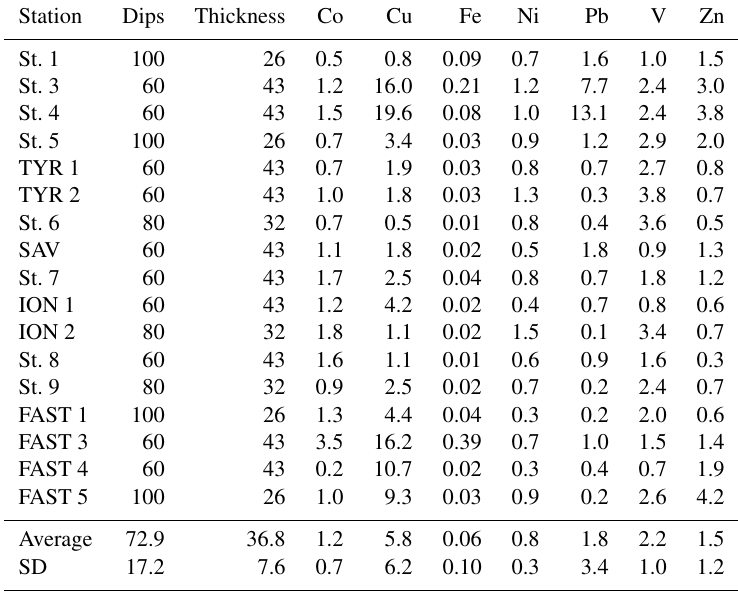
Table 4. Number of dips conducted to collect 500mL of SML, thickness (µm) of the SML and calculated residence times (h) of particulate metals in the SML derived for aerosol